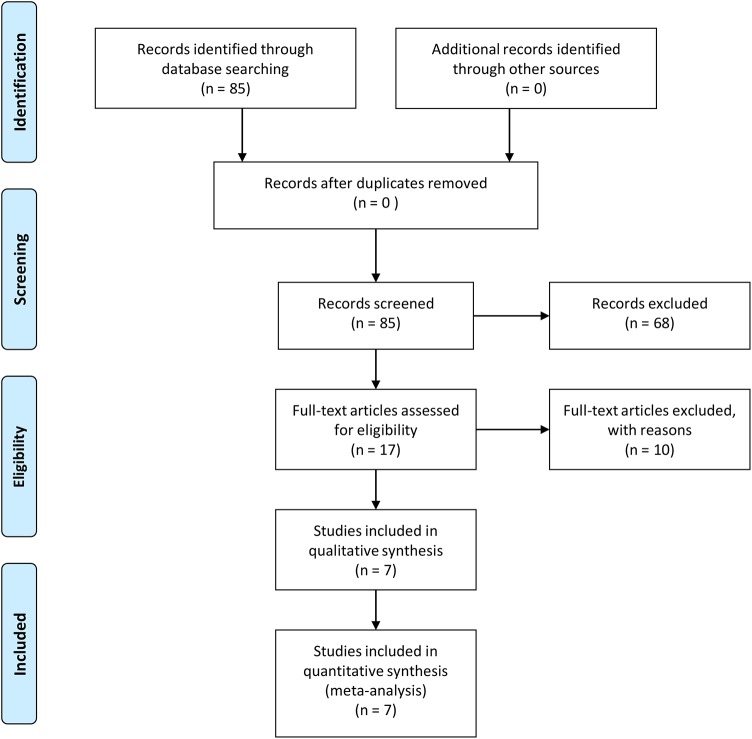
PRISMA Flow chart describing the search for relevant studies used in this meta-analysis.